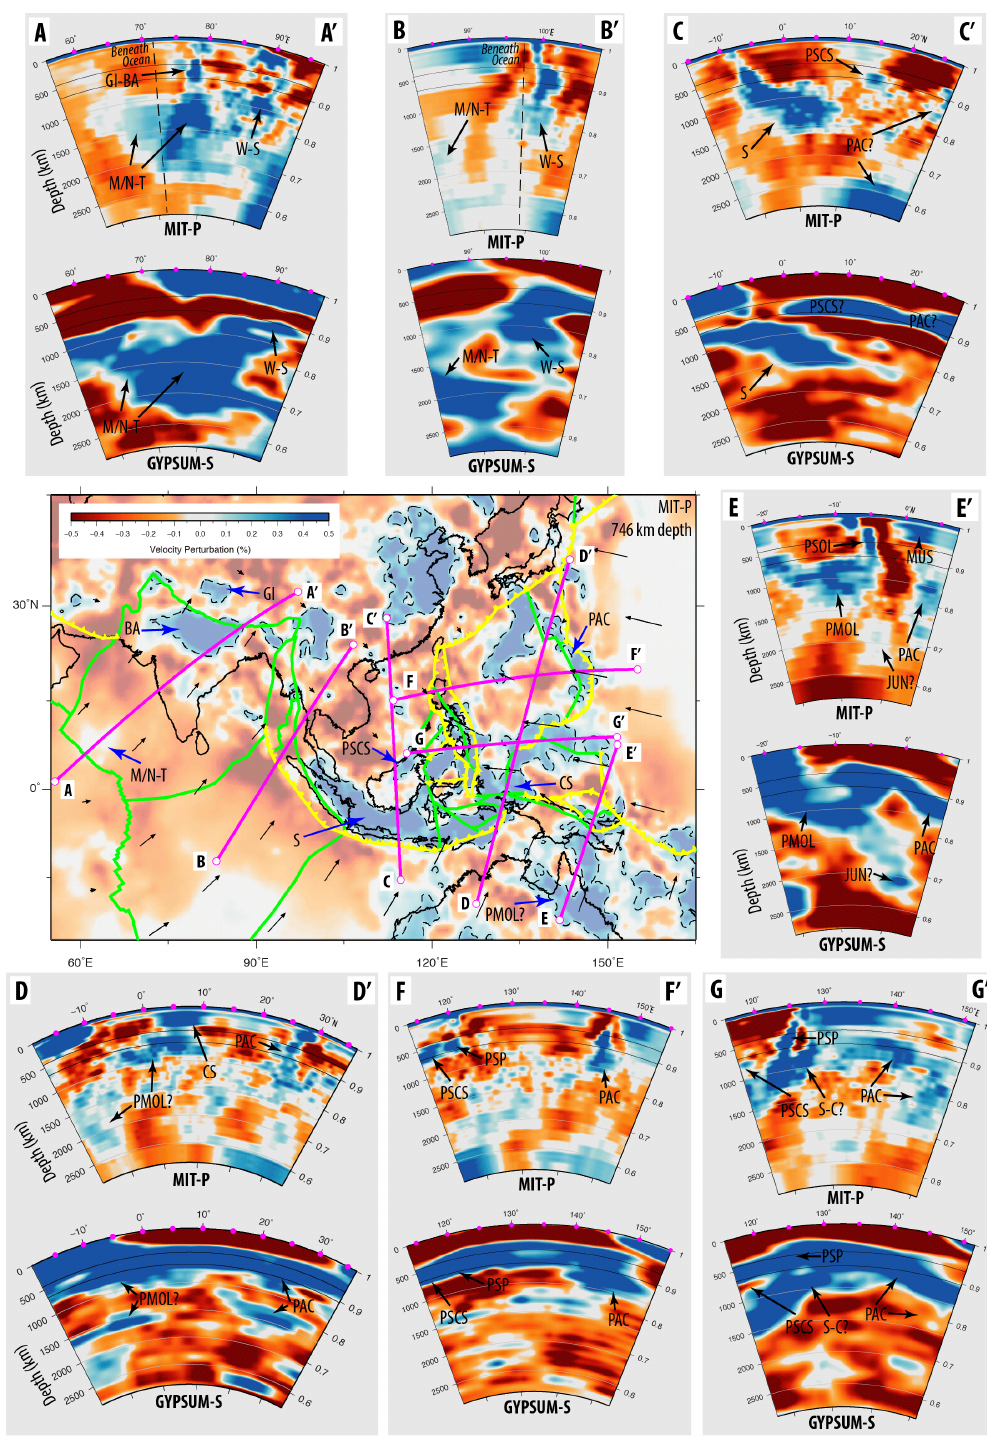
Fig. 10. Vertical sections from MIT-P (Li et al., 2008) and GyPSuM-S (Simmons et al., 2009) seismic tomography models along profiles A to E (magenta lines). The first-order differences between the P- and S-wave models is that the amplitude of the positive seismic velocity anoma- lies significantly diminishes away from continental coverage (e.g., dashed lines in profiles A and B). A depth slice at 746 km from MIT-P is provided for reference with super-imposed present-day coastlines and plate boundaries. Interpreted slab sources are labeled: GI-BA=Greater India–Neo-Tethyan back-arc slab, M/N-T–Meso- and Neo-Tethyan slabs, W-S–Woyla–Sunda slabs, S–Sunda slab, PSCS–proto-South China Sea slab, PAC–Pacific slab, PMOL–proto-Molucca slab, PSOL–proto-Solomon slab, CS–Caroline slab, PSP–Philippine Sea Plate slab, S-C=Sulu–Celebes